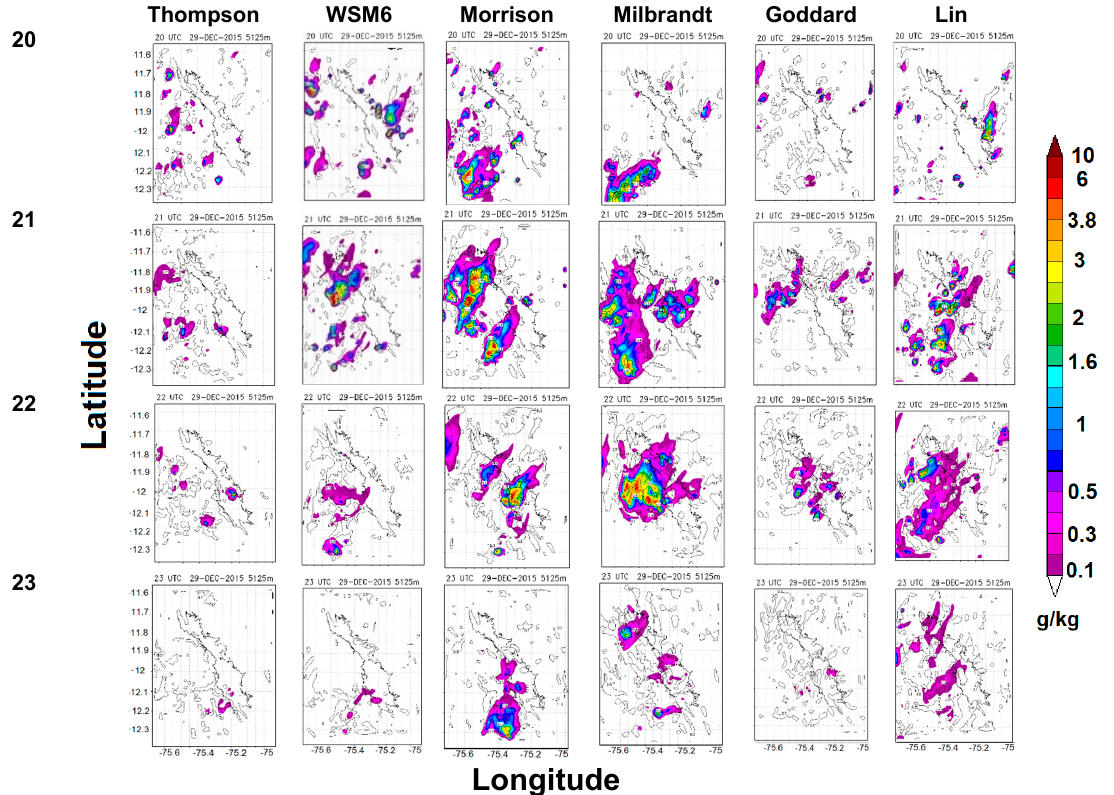
Figure 13. Evolution of the horizontal field of the rainwater + graupel mixing ratio (Q g +r ; g/kg) at the WRF output level of 5.1 km m every 30 min. from 20:00 UTC to 23:00 UTC for CRE1.